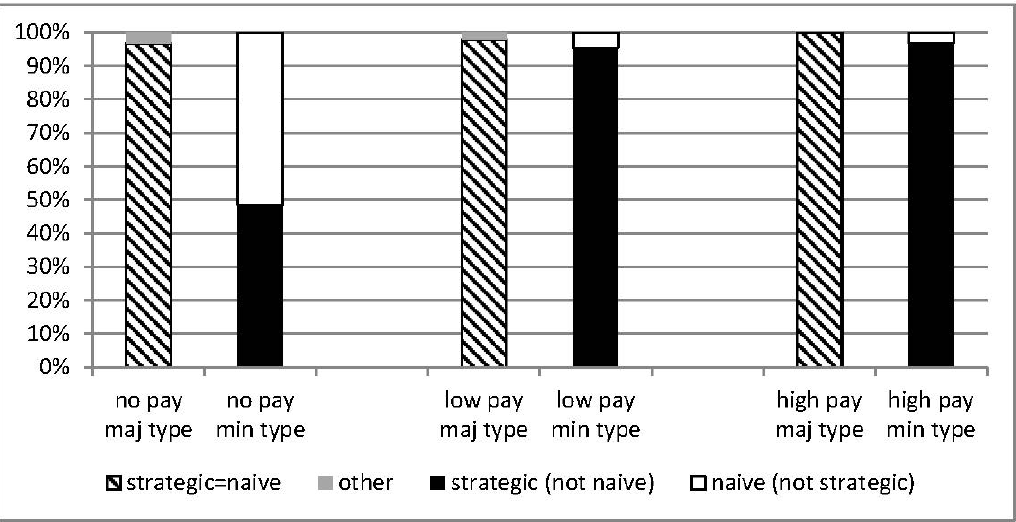
Figure 2. Individual behavior under Full Information